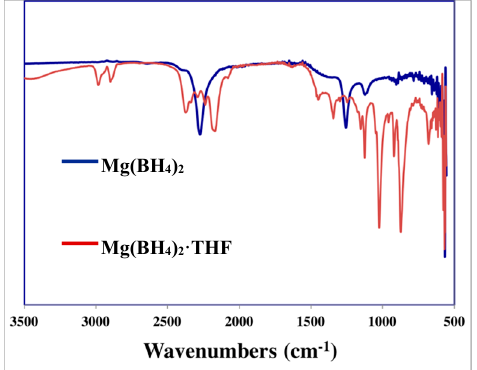
Figure 2. Attenuated Total Reflectance-Infrared spectra of unsolvated Mg(BH 4 ) 2 blue spectra with simple B–H stretching region and Mg(BH 4 ) 2 · THF red spectrum with complex B–H stretching frequency.